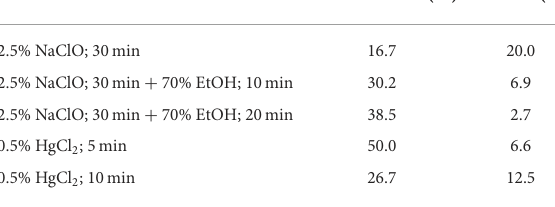
TABLE 1 Percentage of disinfection and shooting of sea knotgrass explants subjected to different sterilization treatments and cultured in MS medium for 30 days ( n =